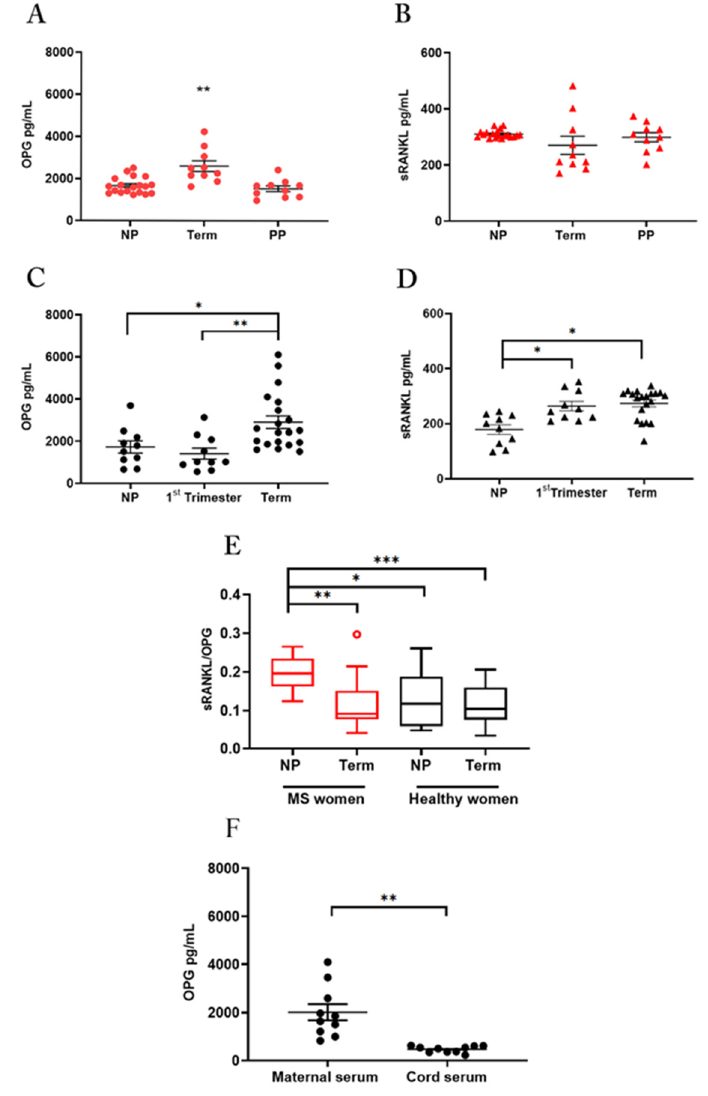
Figure 1. OPG and sRANKL in serum samples OPG and sRANKL in serum of MS women ( A , B ): ELISA assay for OPG ( A ) and sRANKL ( B ) in serum from non-pregnant women of reproductive age (NP; n = 19), at term of gestation (Term; n = 10) and in the post-partum period (PP; n = 10). OPG and sRANKL in serum of healthy women ( C , D ): ELISA assay for OPG ( C ) and sRANKL ( D ) in serum from healthy non-pregnant women of reproductive age (NP; n = 10), pregnant women, at first-trimester (1 st Trimester; n = 10) and term of gestation (Term; n = 20). Serum sRANKL/OPG ratio in MS and healthy women ( E ): sRANKL/OPG ratio for MS patients, (non-pregnant: NP, n = 19; at term of gestation: Term, n = 10) and healthy women (non-pregnant: NP, n = 10; at term of gestation: Term, n = 20). Red circle in MS at term identifies one outlier. OPG quantification in paired maternal and cord serum ( F ): ELISA assay for OPG levels in paired maternal and cord serum (n= 10 donors). Each symbol represents a unique donor and mean ± SEM is shown for data ( A )–( D ) and ( F ). Data are presented as box-whisker plots in ( E ). Significance was determined with the Kruskal–Wallis test for multiple comparisons for data ( A )-( E ) and paired t-test for data in ( F ). *, p < 0.05; **, p < 0.01; ***, p < 0.001.